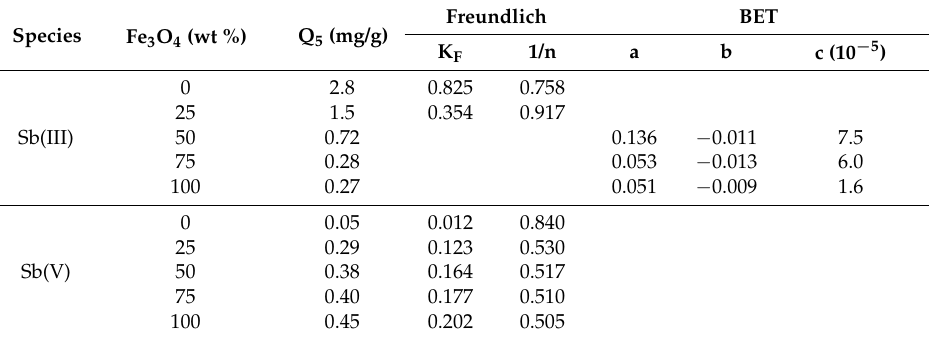
Table 1. Fitting parameters of adsorption isotherms.